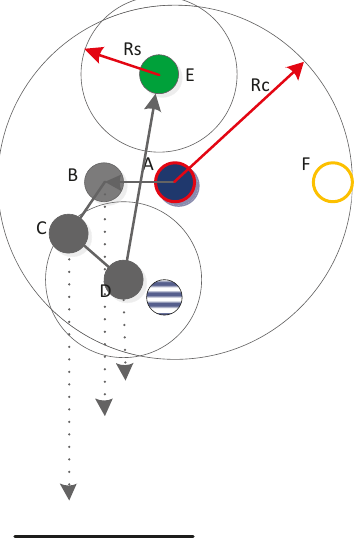
Figure 3. Second example of node